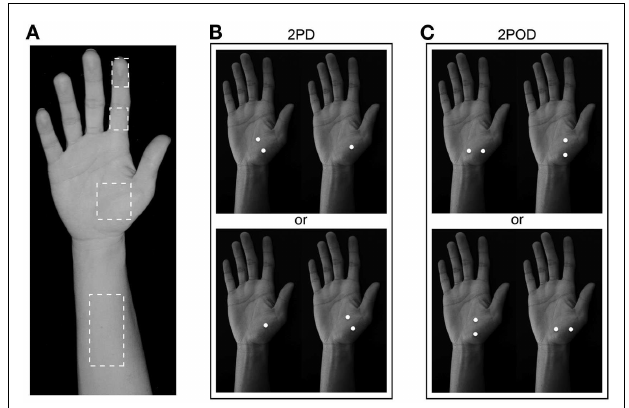
FIGURE 2 |Two-interval forced-choice perceptual tasks . (A) The four test locations are indicated (dashed outlines): forearm, palm, finger base, and fingertip. (B) 2PD task (shown on palm as an example). Participants reported whether the two-point stimulus preceded (upper) or followed (lower) the one-point stimulus. (C) 2POD task (shown on palm as an example). Participants reported whether the horizontally oriented two-point stimulus preceded (upper) or followed (lower) the vertically oriented two-point stimulus.